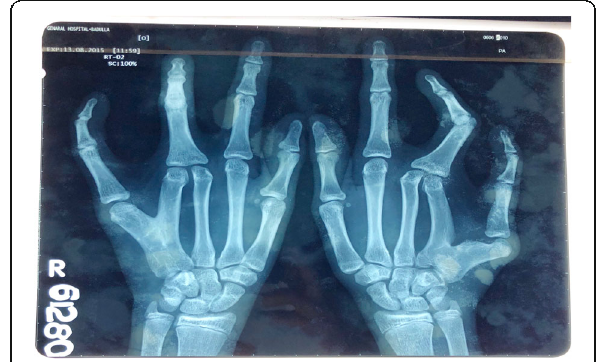
Fig. 3 X- ray findings of the proband II.1 with fused 4th and 5th metatarsal